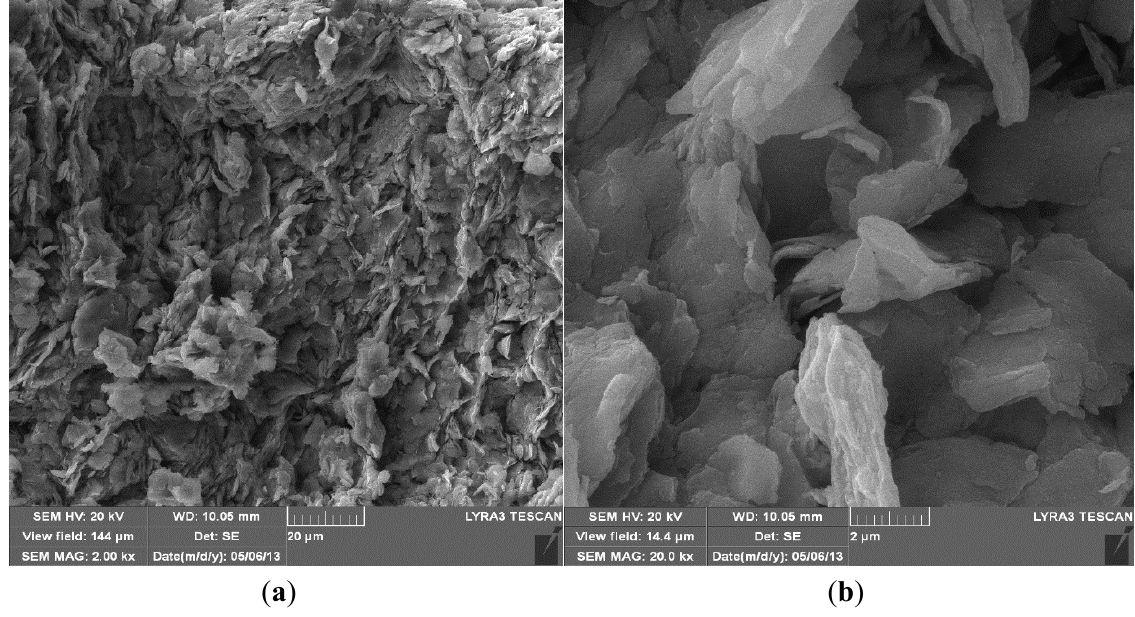
Figure 8. SEM micrographs of fractured surfaces ( a ) lower and ( b ) higher magnification of sintered using a pressure of 50 MPa, heating rate of 200 °C/min, sintering temperature of 550 °C, and sintering time of 15